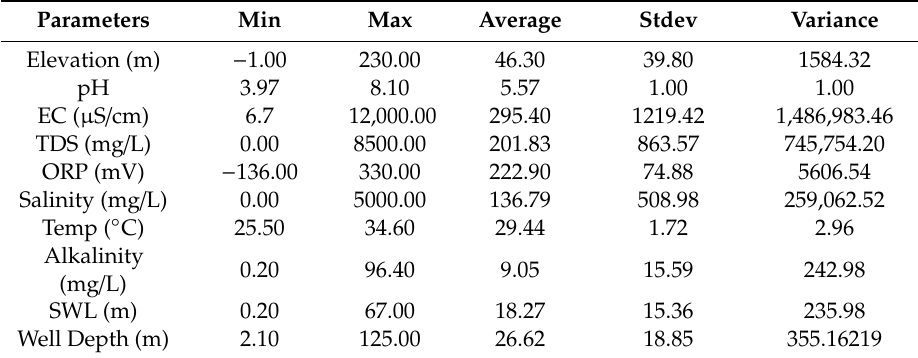
Table 2. Regional electrical